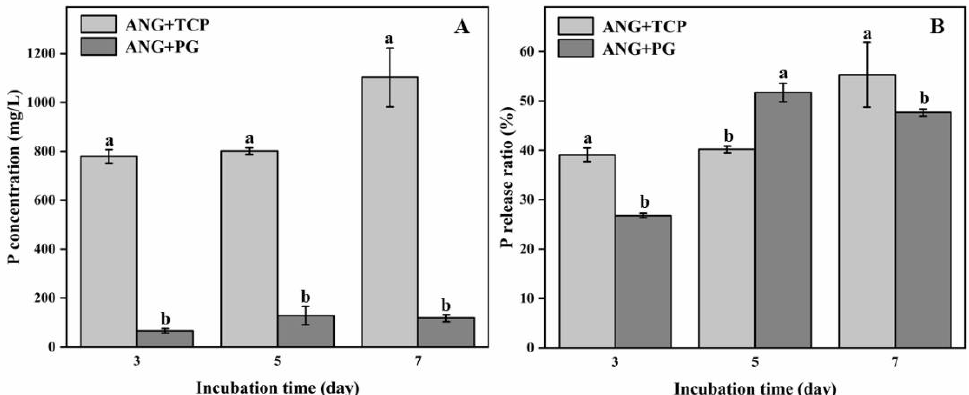
Figure 2. The P concentration ( A ) and P release ratio ( B ) between ANG + TCP and ANG + PG treatments during incubation (3, 5, 7 days). The different lower-case letters indicate a significant difference between the treatments ( p < 0.05). The significant differences among the treatments were identified by the Tukey test ( p < 0.05).